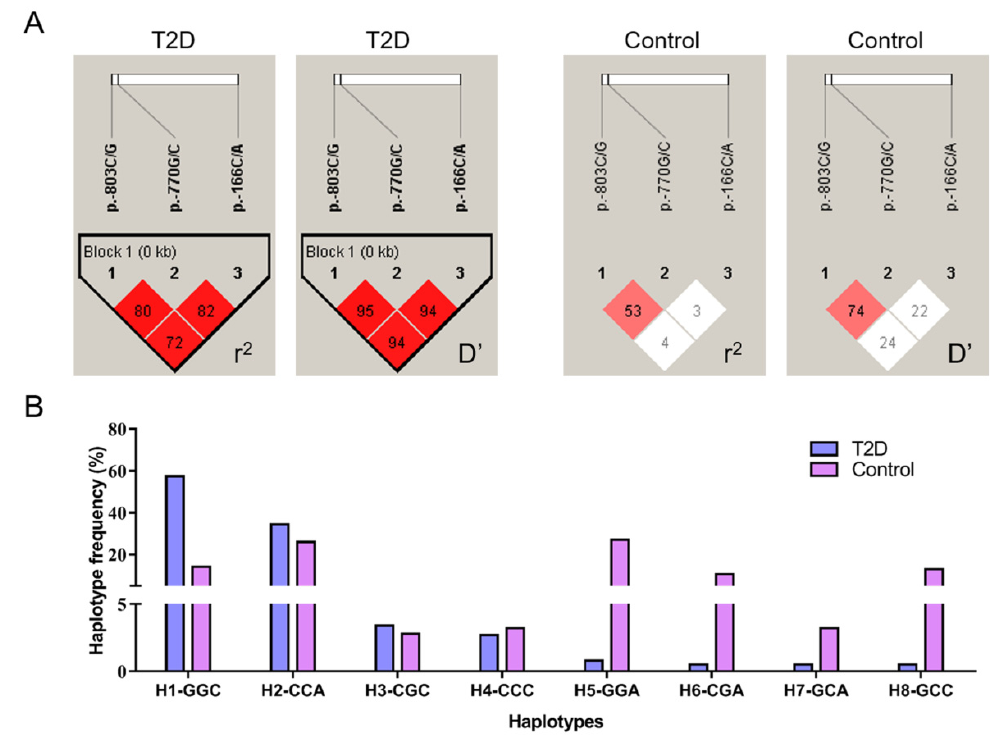
Figure 2. Linkage disequilibrium analysis and haplotype block construction of the SIRT2 variants. ( A ) Linkage analysis (r 2 and D’) of the three SNPs in the T2D and control groups. ( B ) Haplotype frequencies of the three loci in both T2D and